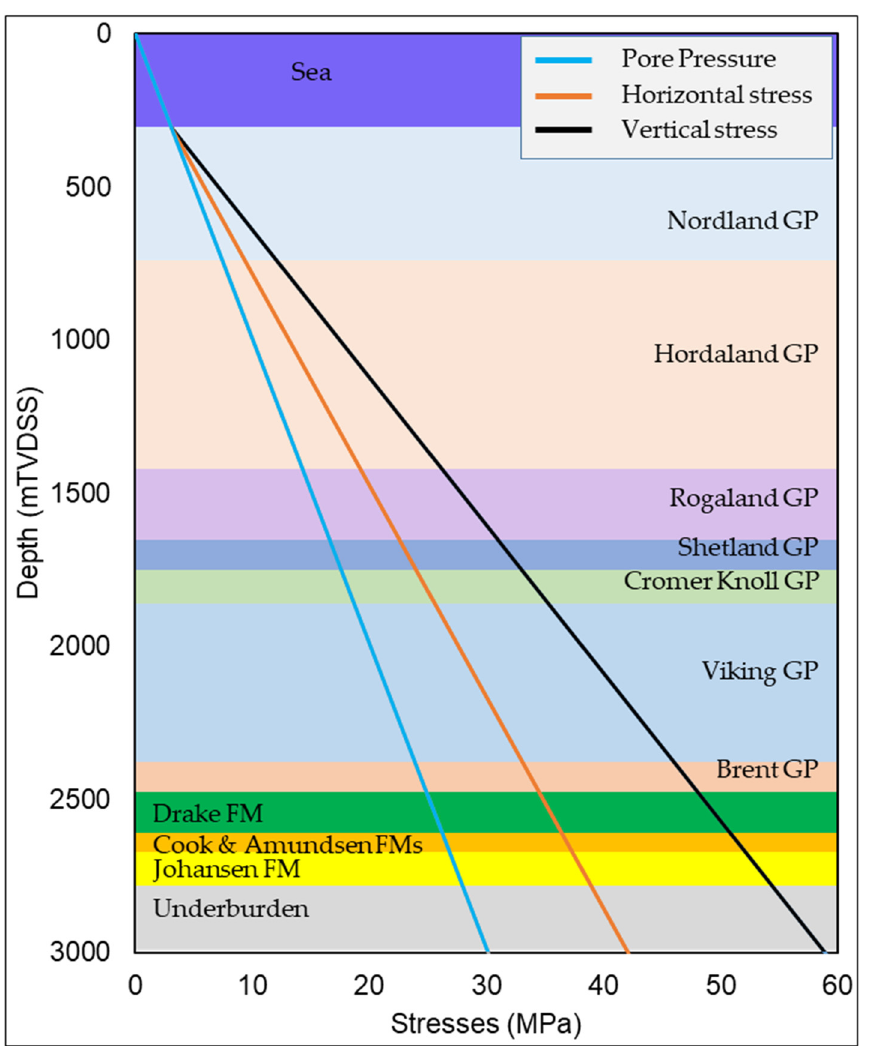
Figure 3. In situ stress-state profile in the well 31/5-7 (Aurora injection well) assuming normal faulting regime with isotropic horizontal stress condition. Please note that the minimum horizontal stress is estimated based on XLOT data from the Troll area (adapted from [48]).